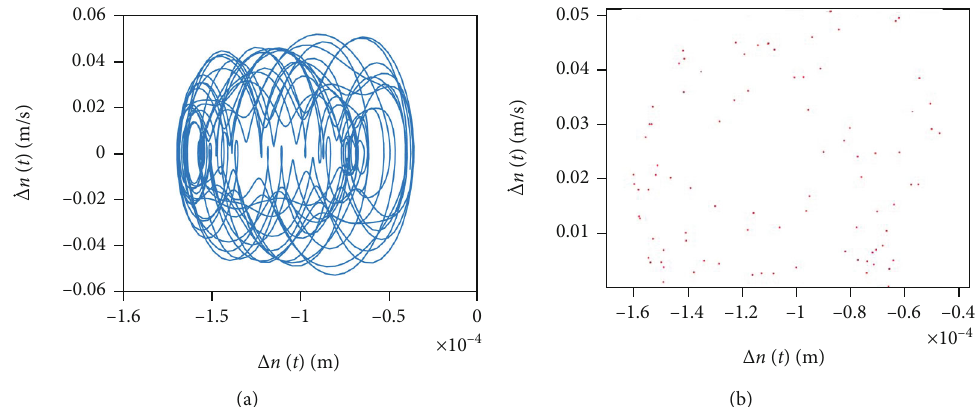
Figure 28: When the rotation speed of the system is 4800r/min: (a) relative displacement velocity and (b) the corresponding diagram of